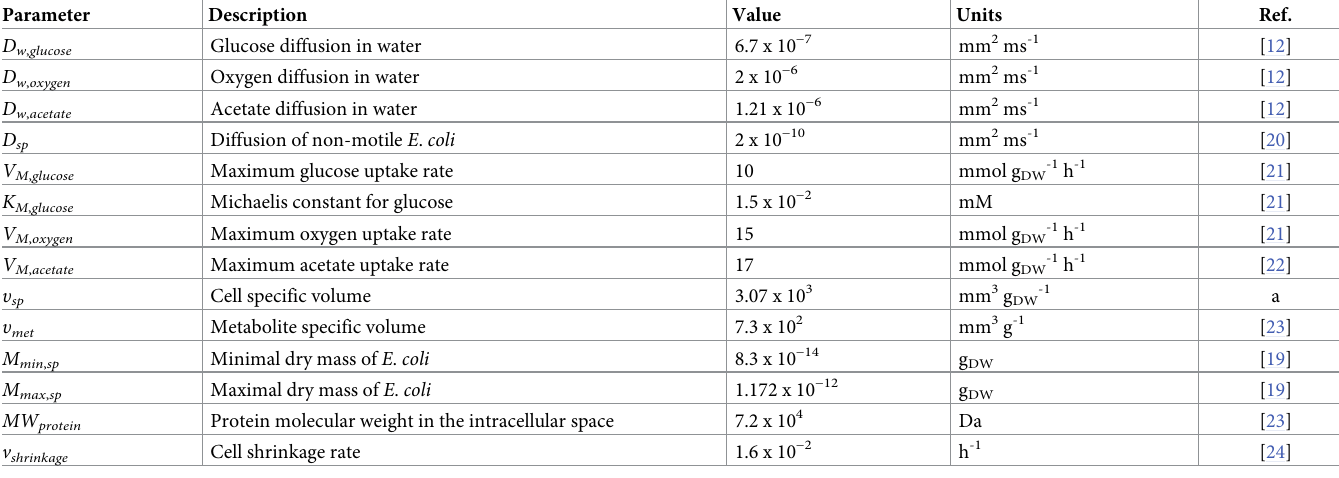
Table 1. Parameters used in CROMICS simulations.